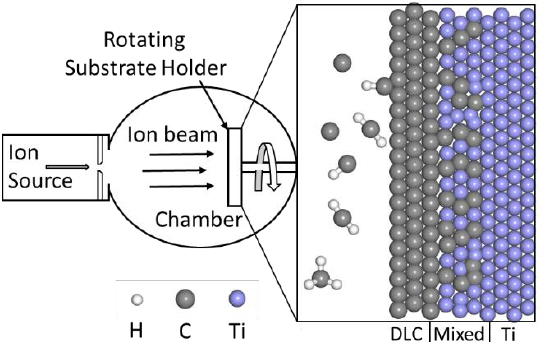
Figure 1. Deposition schematic diagram of DLC film by IBD method.